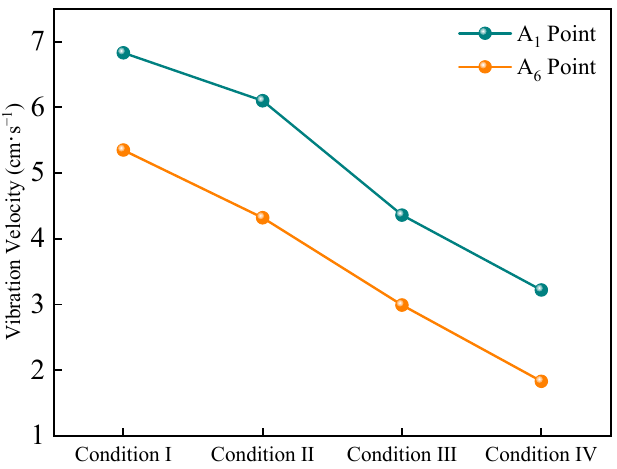
Figure 9. The peak vibration velocity decay curve of the A 1 and A 6 points.